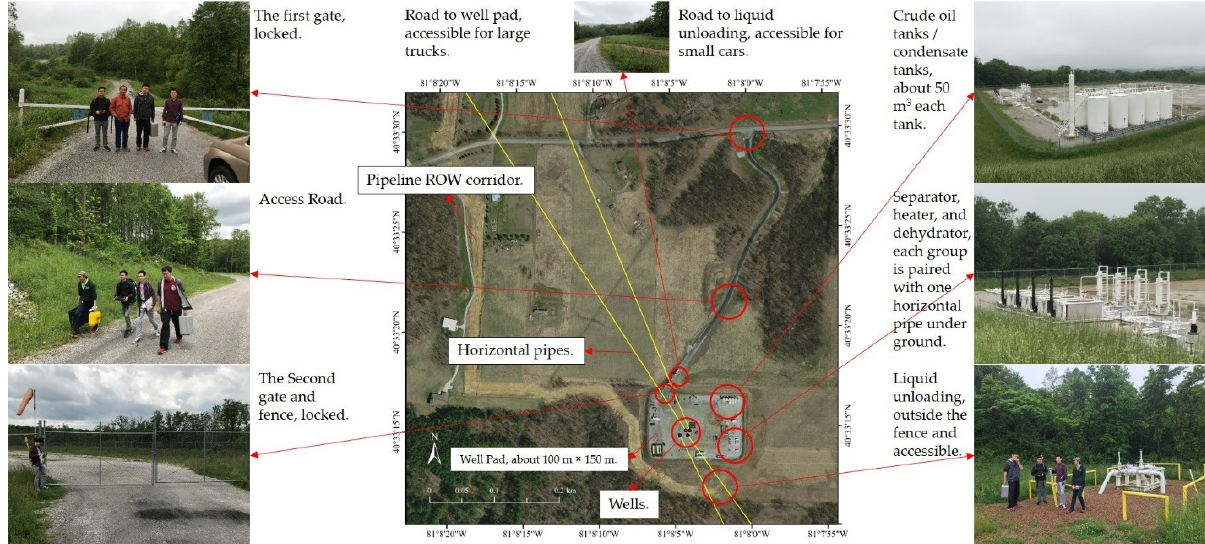
Figure 1. The unconventional shale oil and gas extraction system associated with a well pad. The investigators who participated in this field survey are Dr. Song Shu, Dr. Hongxing Liu, Dr. Bo Yang, and Dr. Bin Wu (from left to right in front of the first gate). The aerial image (middle) was collected from the Ohio Statewide Imagery Program (OSIP), captured in 2014. Field survey photos were captured on 26 May 2017.